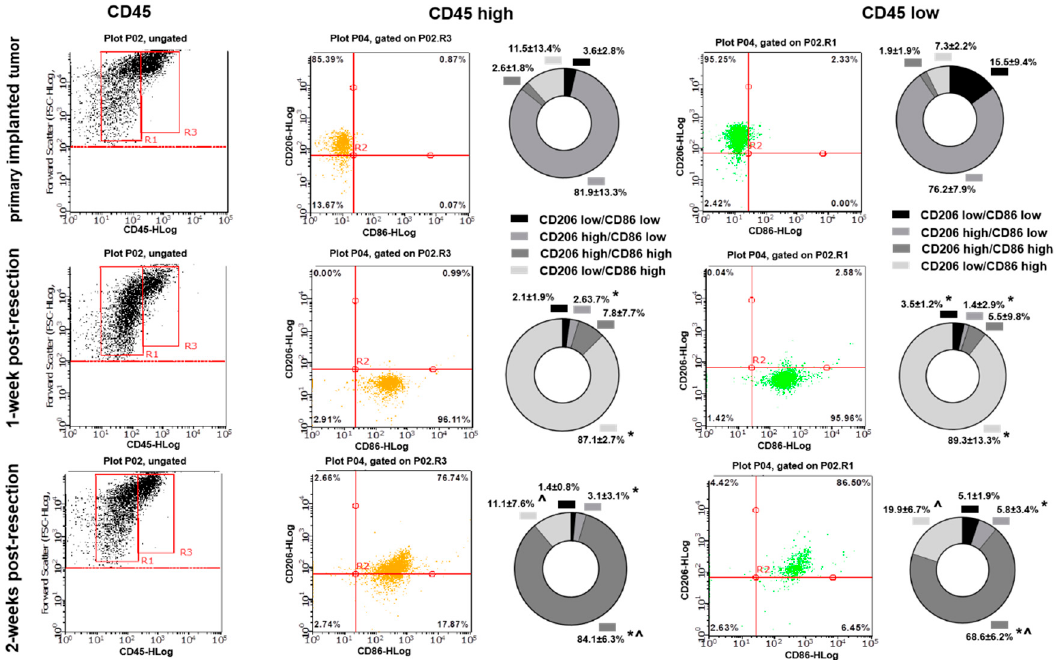
Figure 5. Flow-cytometric analysis of CD86 and CD206 expression in tumor-infiltrating myeloid cells purified from primary implanted tumors and tumors regrown 1 and 2 weeks after resection in the GL261-C57BL/6 mouse glioma implantation model. The left column contains forward scatter (FSC) vs. CD45 plots demonstrating CD45 populations: low (R1) and high (R3). The middle column contains CD86 vs. CD206 events plotted from CD45 high and CD45 low populations. Graphs showing proportional composition of myeloid cell markers are shown in the right columns. Mean + S.E., and significant differences from primary implanted tumors (*) and from 1-week post-resected tumors (^) are shown ( p < 0.005, N = 6).